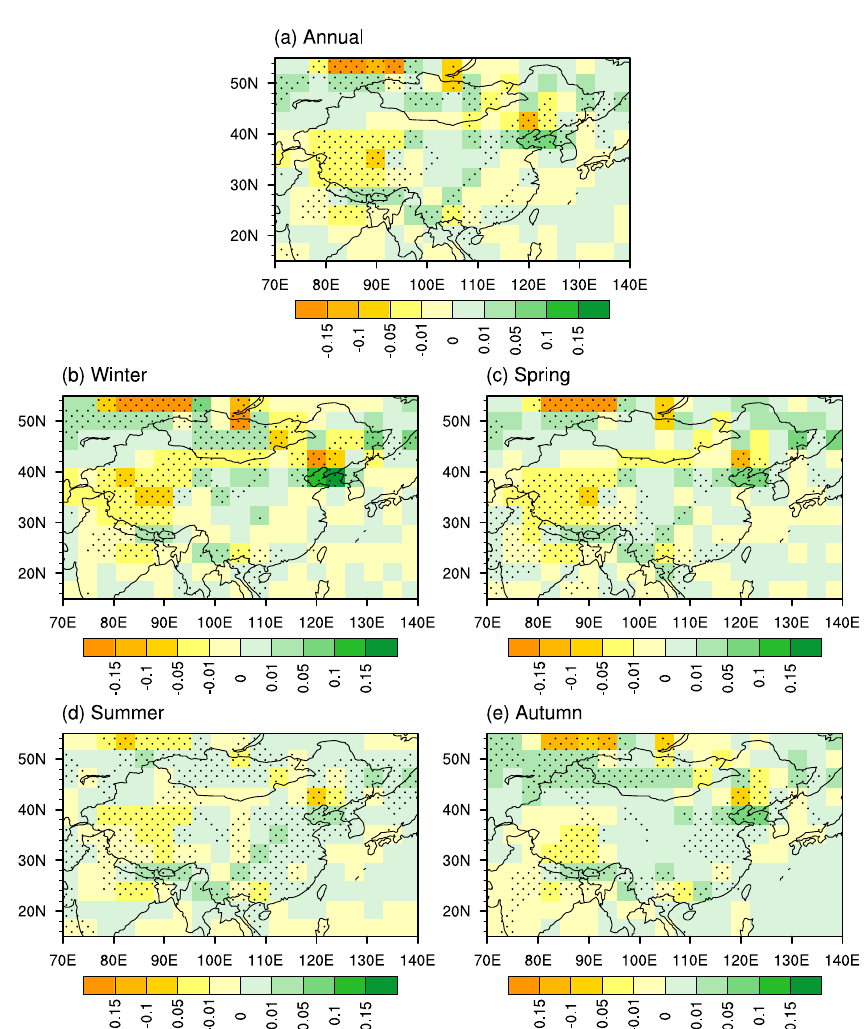
Fig. 10. Annual and seasonal surface albedo changes between (AOV(6ka)–AOV(0ka)) and (AO(6ka)–AO(0ka)) experiments. The areas exceeding 90% confidence level are